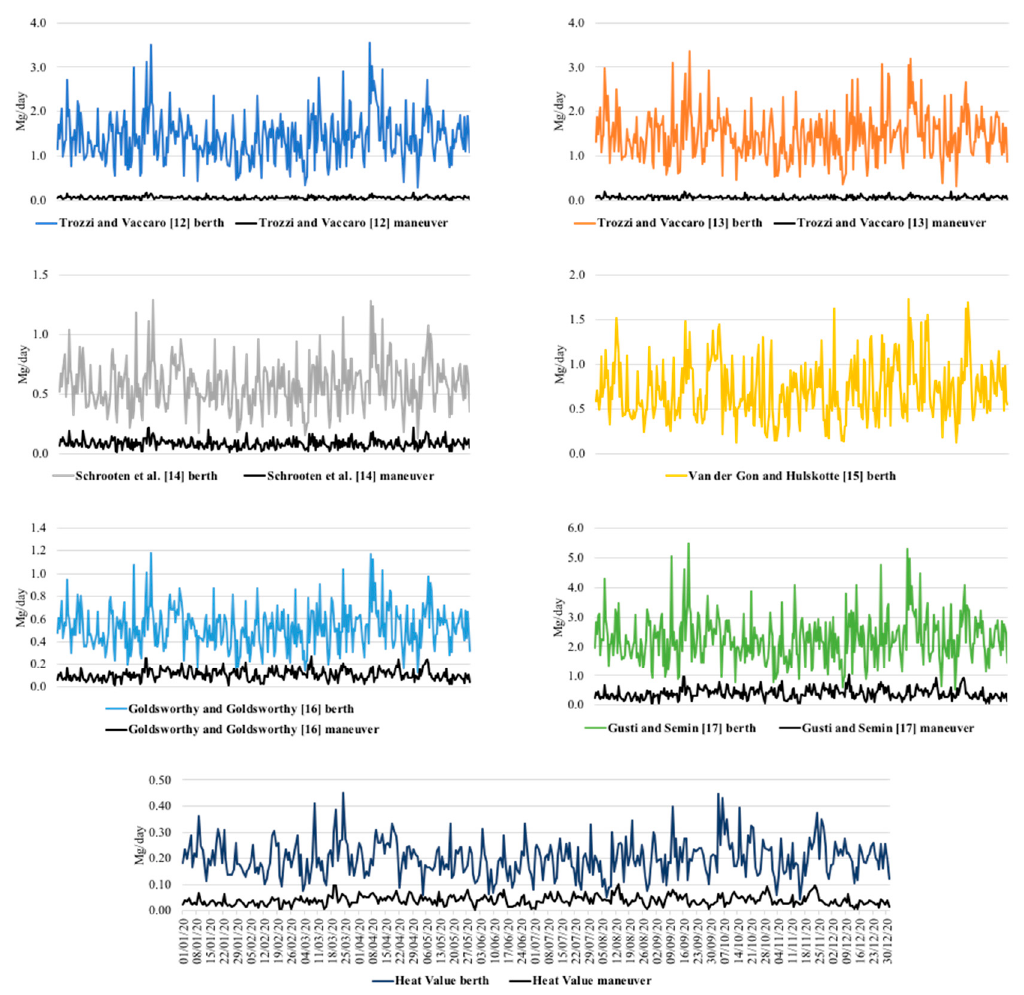
Figure 4. Atmospheric SO 2 emissions (Mg/day) in berthing and maneuvering positions for each method.